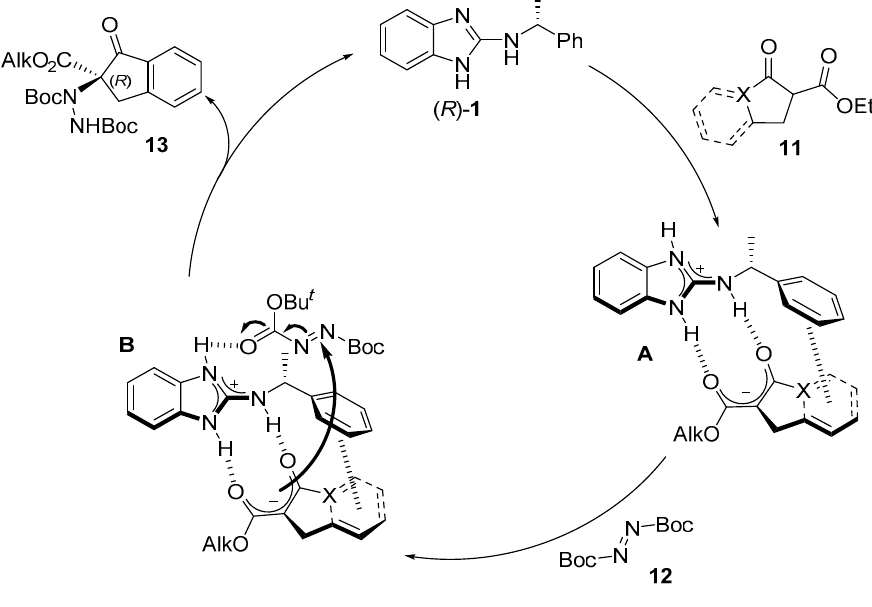
Figure 4. Proposed reaction mechanism.